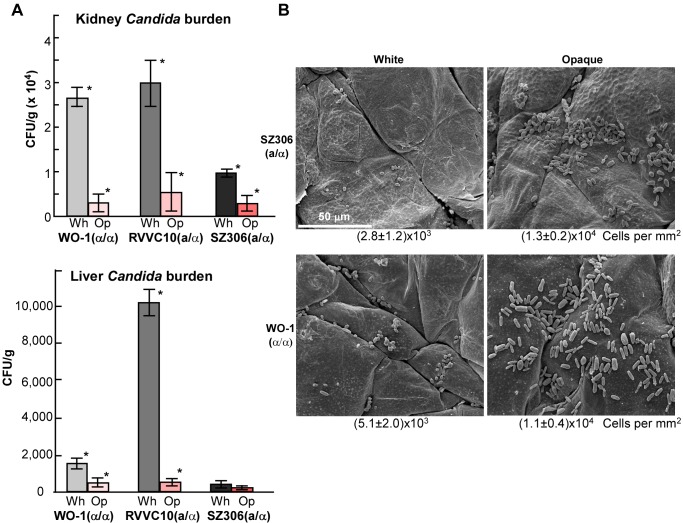
White and opaque cells differ in fungal burden in systemic and cutaneous infections.(A) Fungal burdens of the kidneys and livers of systemically infected mice are shown. Each male mouse was intravenously injected with 200 µl 1× PBS containing 2×106 cells via the tail vein. Three to four mice per strain were used for the injections. Mice were sacrificed on the 3rd day postinfection. CFUs, colony-forming units. White and opaque cells of an MTL
a/α strains, RVVC10 and SZ306, were tested. The MTLα/α strain, WO-1, served as the control. Error bars stand for standard deviation (SD). * indicated significant difference (op. versus wh., Student's t test p value<0.05). (B) SEM images of skin colonization in a newborn mouse model. White and opaque cells of an MTL
a/α strain, SZ306, were tested. The MTLα/α strain, WO-1, served as the control. The number of colonized cells (average ± SD, cells per mm2) is shown below the images. Five randomly selected fields of view were counted. The number of opaque cells that colonized the skin was significantly higher than that of white cells (Student's t test p value<0.002).